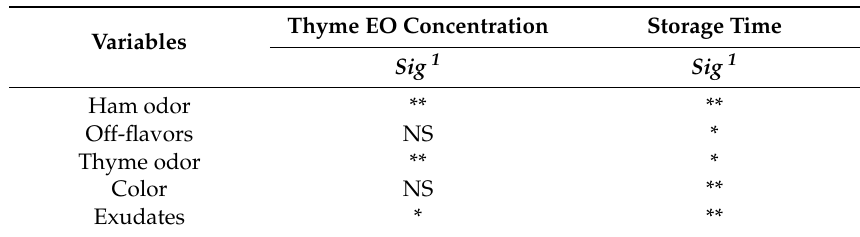
Table 6. Significance of the effect of factorsthyme EO concentration and storage time on sensory attributes in RTE meat packaged during refrigerated